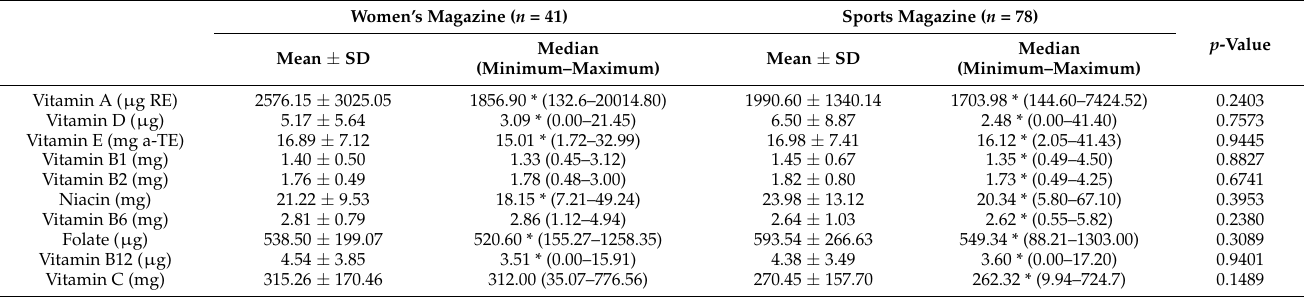
Table 3. The vitamin intake within the assessed single-day menus, stratified by type of magazine, for the diets published in the women’s magazine and the diets published in the sports magazine.